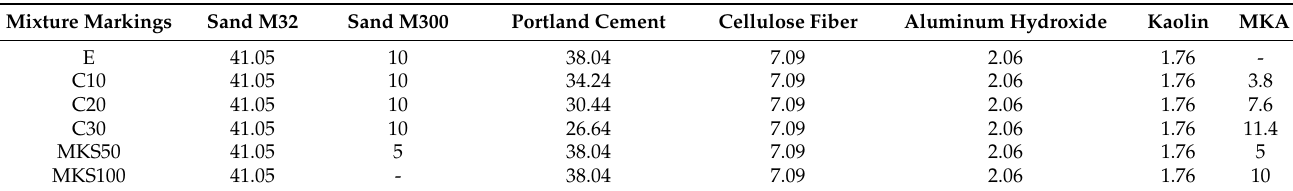
Table 2. The number of raw materials in the different mixtures in percentages.